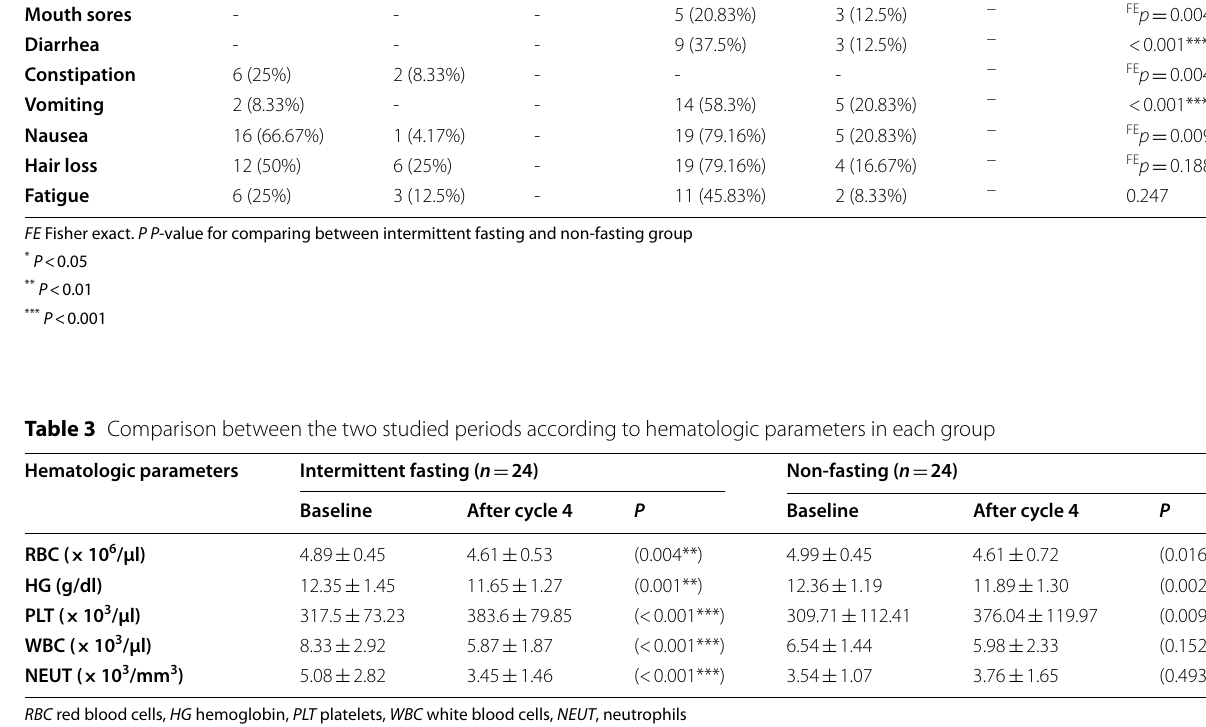
RBC red blood cells, HG hemoglobin, PLT platelets, WBC white blood cells, NEUT , neutrophils Data presented as mean SD. P P -value for comparing between baseline and after cycle 4 in each group ± * P < 0.05 ** P < 0.01